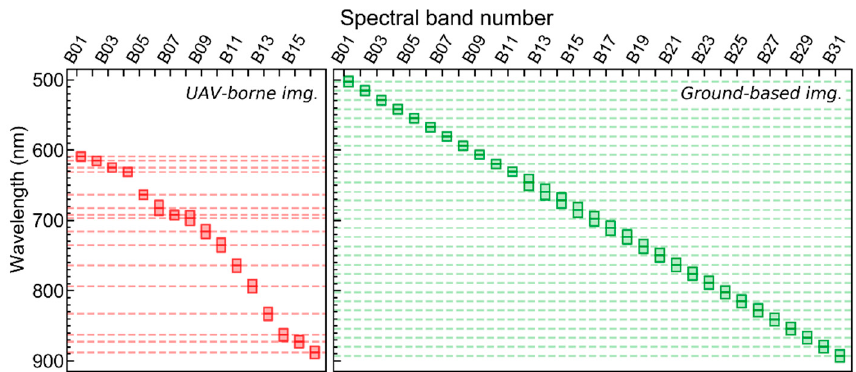
Figure 2. Specifications of the data acquired with the hyperspectral imaging system mounted on the UAV platform (red boxes, 16 spectral bands) and on handheld configuration (green boxes, 31 spectral bands; Section 2.3). Center line in each box indicate spectral band center and extremities for the full width at half maximum for each band (FWHM; varying between 13 and 21 nm for UAV data and between 13 and 23 nm for ground-based images).